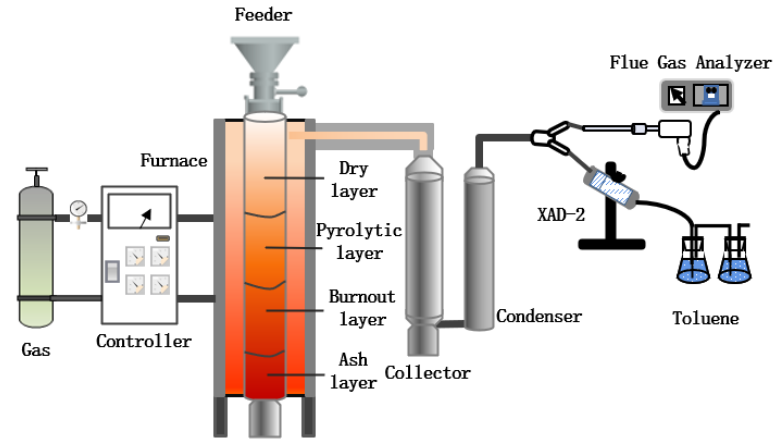
Figure 1. Schematic diagram of the pyrolysis furnace. Table 3. Experimental